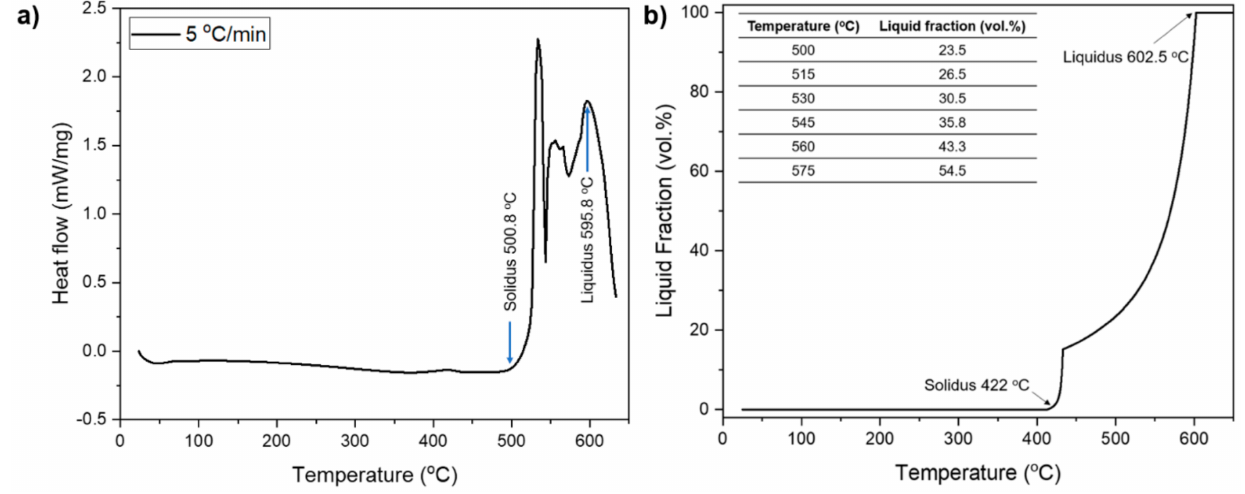
Figure 6. Thermal analysis of AZ91 alloy, ( a ) DSC of as-received powder at 5 ◦ C/min, ( b ) temperature dependence of liquid fraction for Mg- 8.79 wt. % Al- 0.46 wt. % Zn- 0.17 wt. % Mn- 0.05 wt. % Si alloy determined by thermodynamic